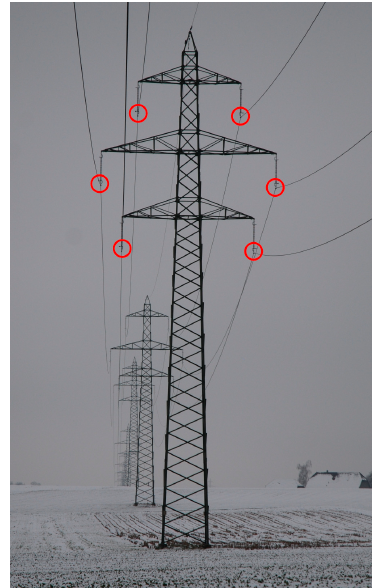
Figure 4. Position of the conductors on the tower, case of the 2 × 220 kV line in Iffwil. The position of the attachment point is determined by the position and geometry of the tower and the length of the isolators. Of the geometric data, only the line sag and lateral displacement by wind are variable in time.